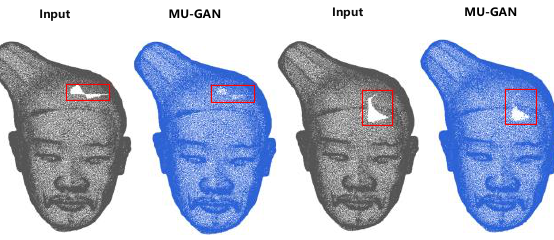
Figure 11. The examples of limited cases.